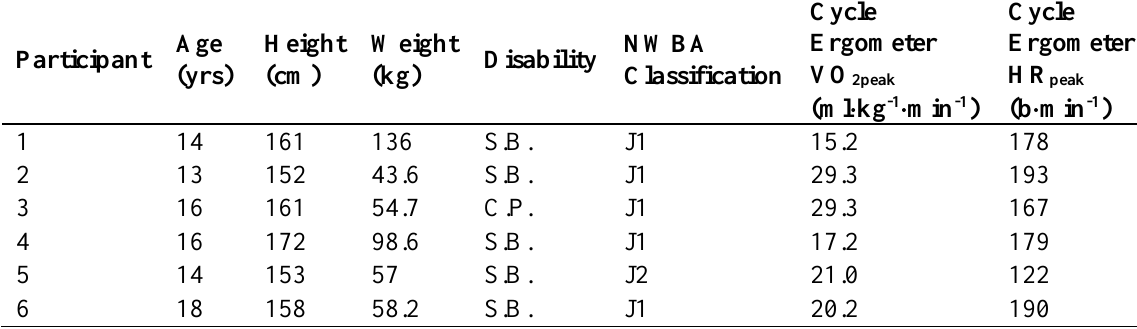
Table 1. Individual participant descriptive